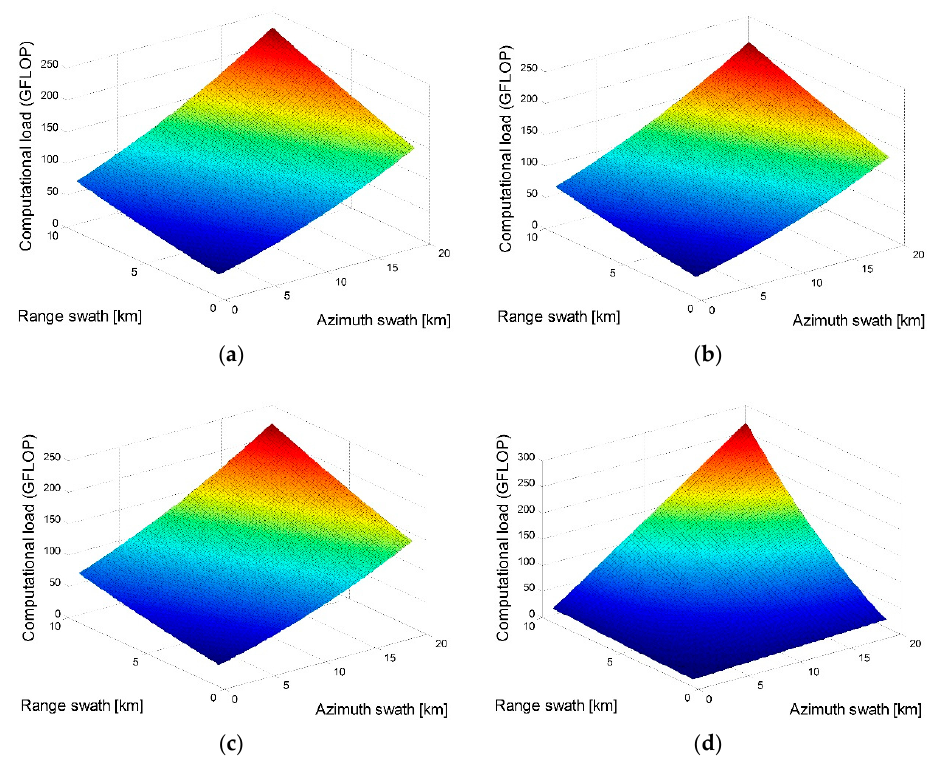
Figure 16. Total computational loads of: ( a ) RDA; ( b ) CSA; ( c ) RMA; and ( d ) MPFA.